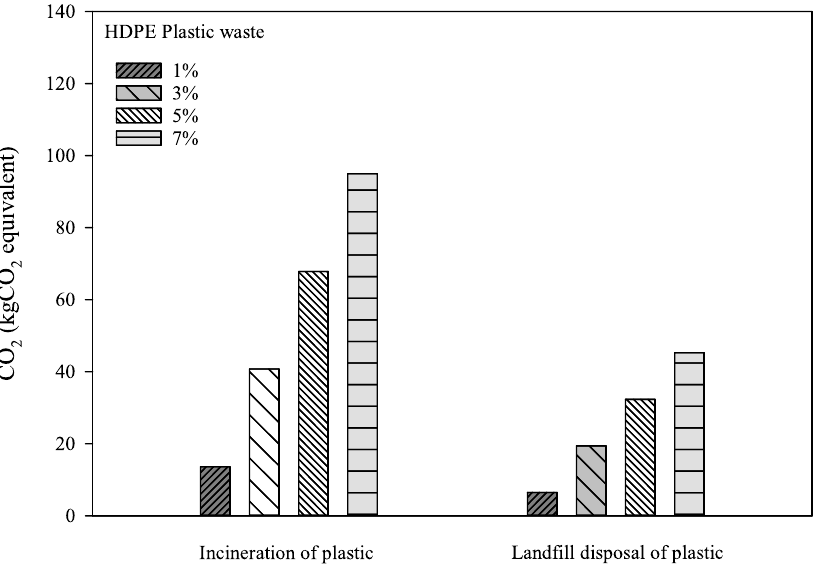
Figure 8. The emission CO 2 -e (kg CO 2 -e/m 3 ) savings of HDPE-ACP. Table 4. The emission factor of HDPE plastic waste